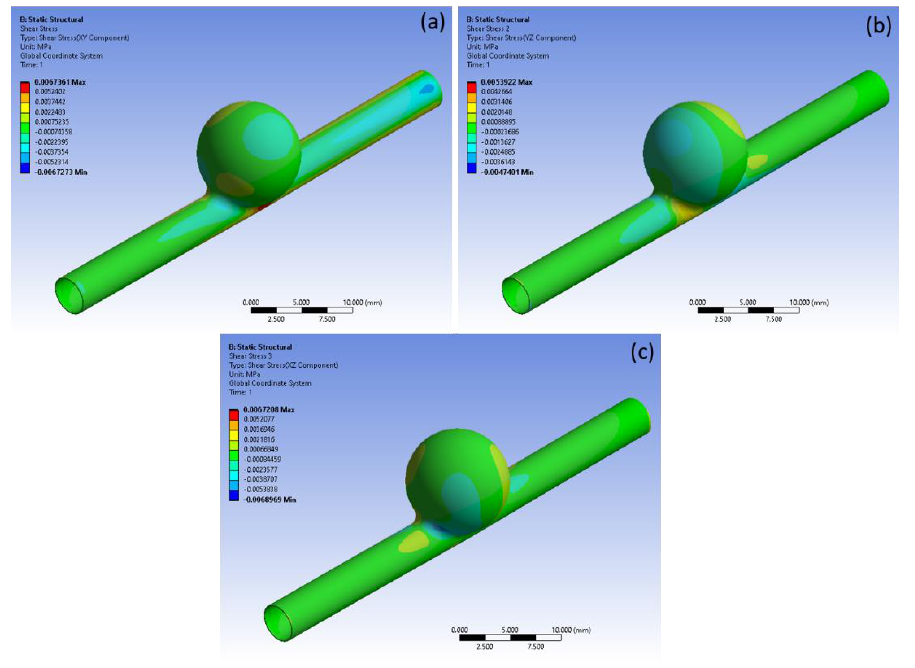
Figure 15. Shear stress to Re = 1000. ( a ) XY, ( b ) YZ and ( c ) XZ component.